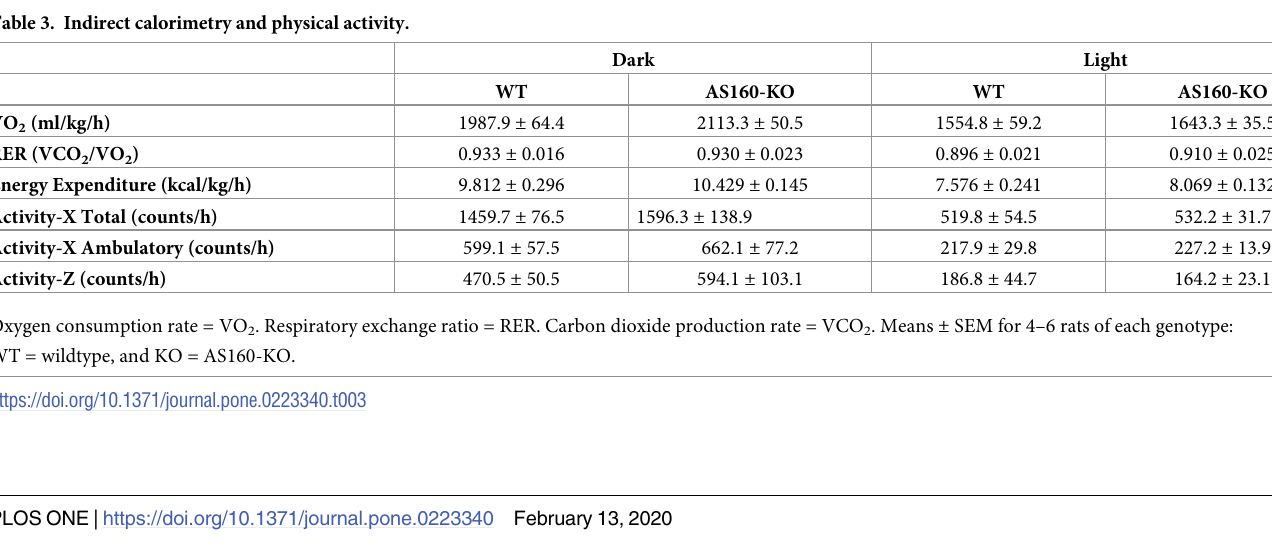
Glucose levels at baseline were slightly (12.6%), but significantly (P < 0.05) greater for WT compared to AS160-KO females (Fig 2A). AS160-KO animals versus WT animals were glucose intolerant as evidenced by higher glucose concentration during minutes 15, 30, 60 of the OGTT (P < 0.005 to 0.001) and on greater glucose AUC (area under the curve) (P < 0.001; Fig 2). Insulin levels at baseline were not significantly different between AS160-KO and WT rats (Fig 2B). The Glucose-Insulin Index (product of the AUC for glucose and insulin in the OGTT), which is an indicator of insulin resistance [33], was significantly greater (P < 0.005) for AS160-KO (4.65 ± 0.87, n = 6) versus WT (1.36 ± 0.15, n = 6) rats.